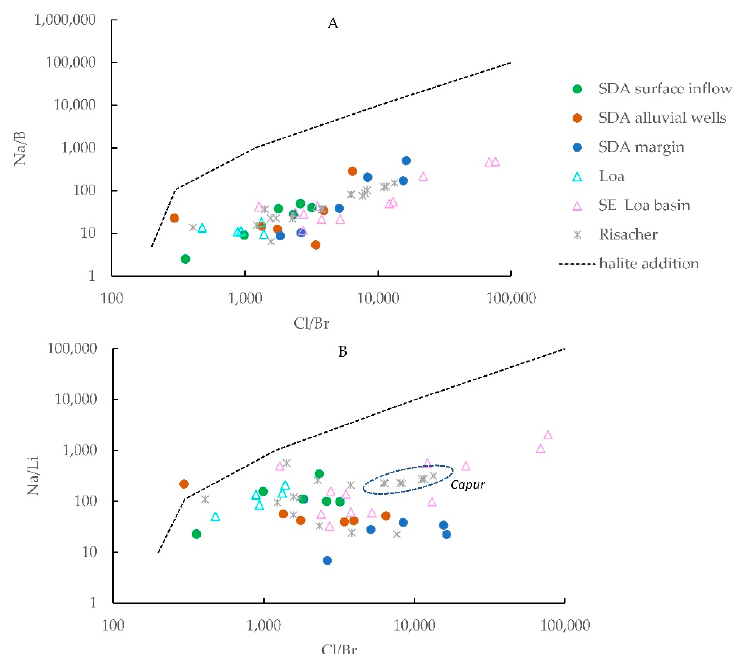
Figure 4. Diagrams showing the relationship between Na / B and Cl / Br ( A ), and Na / Li and Cl / Br ( B ). The dotted line indicates the e ff ect that evaporate dissolution, primarily halite, has on water compositions. The e ff ect on B is shown in ( A ) and ( B ).